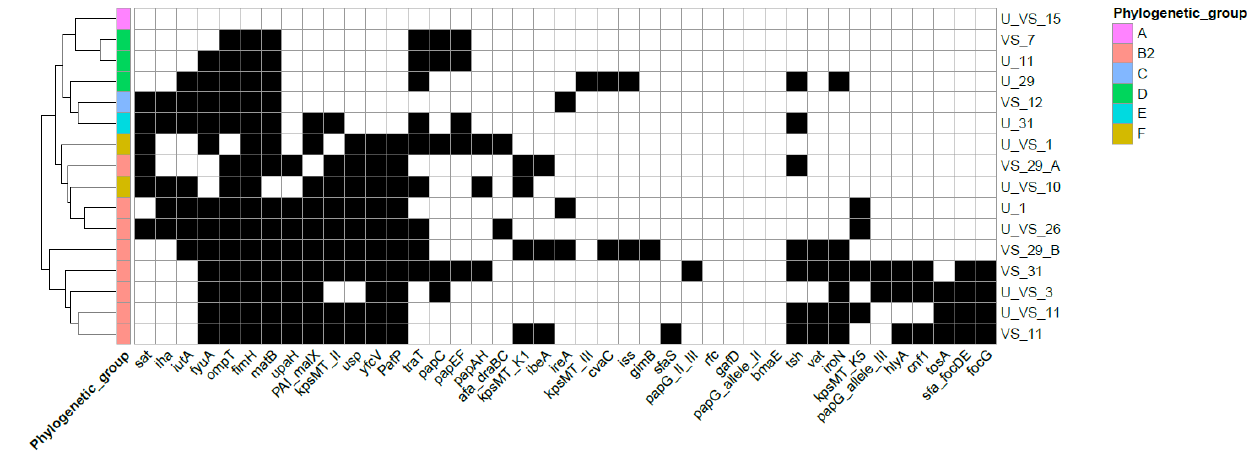
Figure 1. Heatmap representing presence/absence matrix of putative virulence genes among urogenital E. coli from different phylogenetic groups. The dendrogram in the left represents clustering of isolates based on Euclidean distance. Presence or absence of virulence genes is represented as black or white squares, respectively. The right hand side of the figure contains the list of unique E. coli profiles coded with U (for urinary) or VS (for vaginal swab) for origin and a number for identification of donor, according to Table 1.